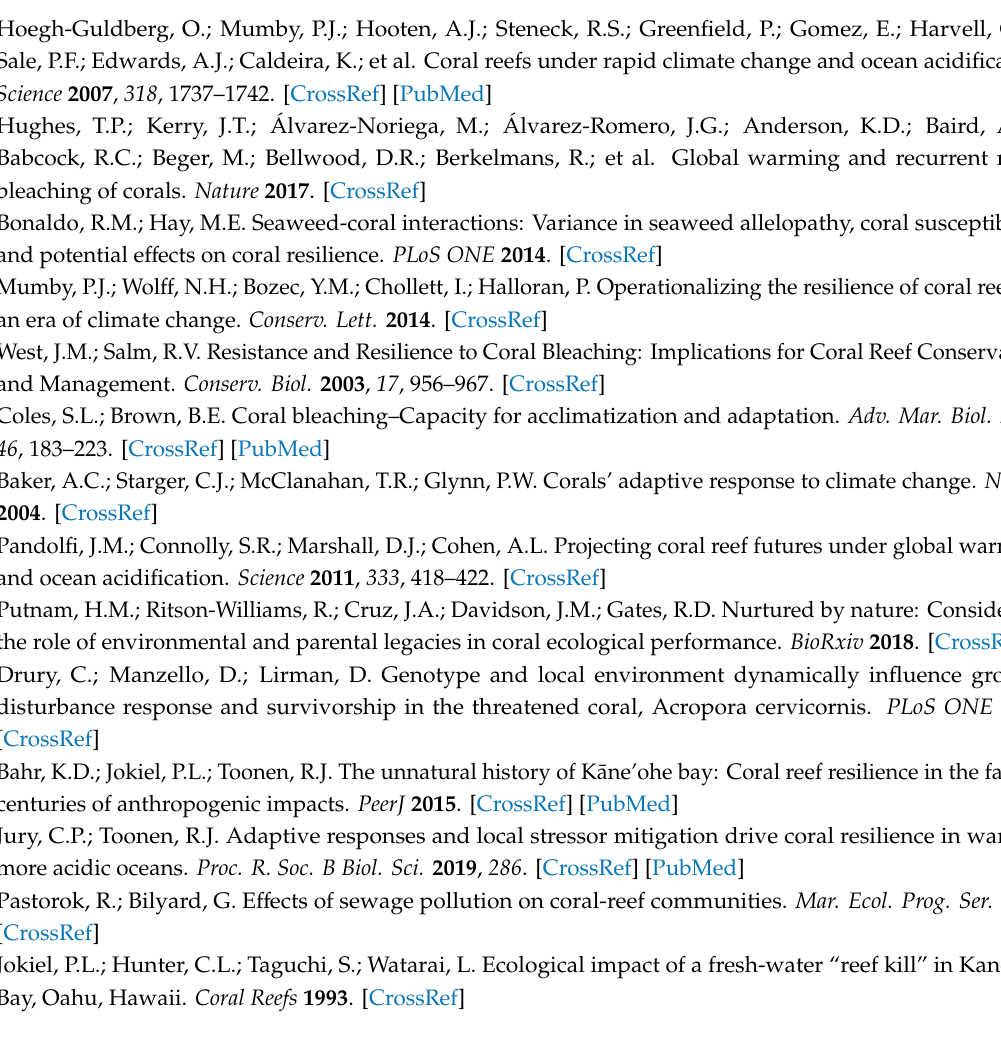
Table S1: results of the linear mixed e ff ects model for P. compressa linear extension; Table S2: results of the linear mixed e ff ects model for M. capitata linear extension; Table S3: results of the linear mixed e ff ects model for M. capitata dry skeletal